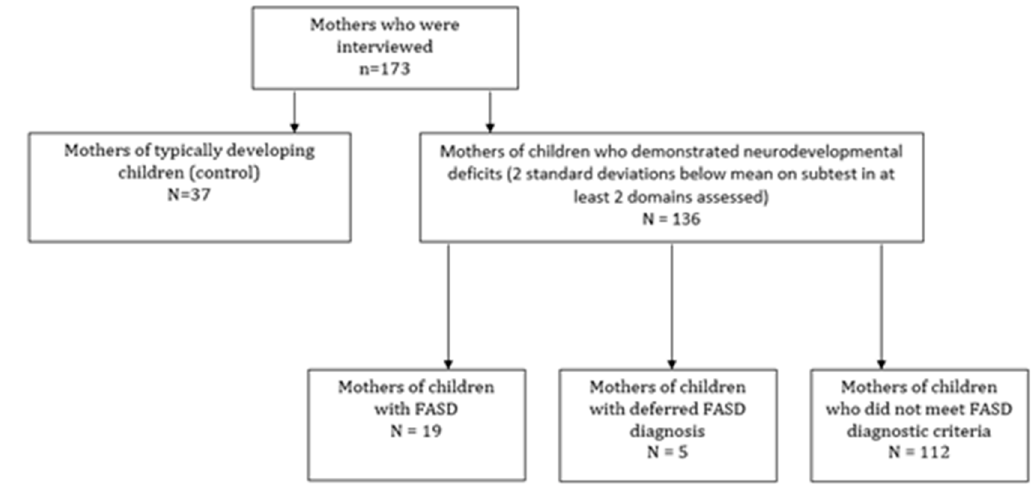
Figure 1. Sampling and recruitment methodology.